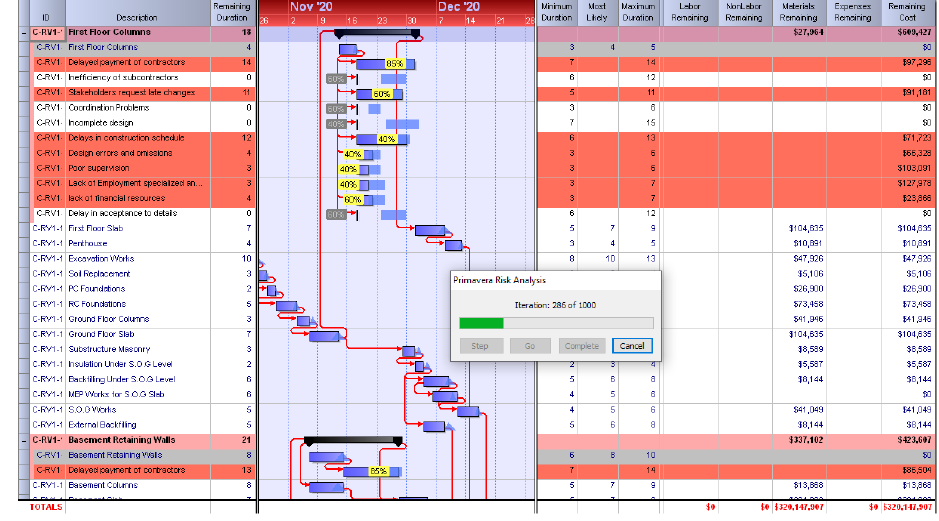
Fig. 7. Running Monte Carlo simulation Fig. 7. Alt Text: Apply a thousand iterations to the largest number of activities by running a Monte Carlo simu- lation.